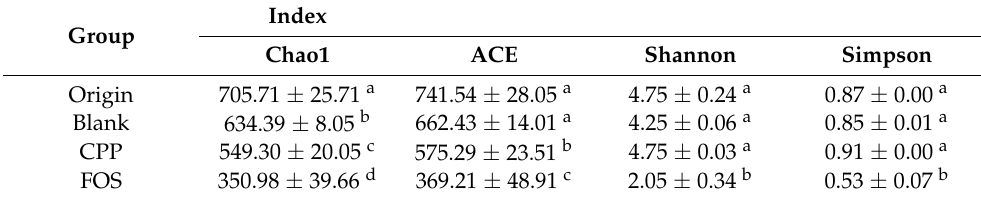
Table 2. Alpha-diversity for origin, blank, CPP, and FOS groups. Group